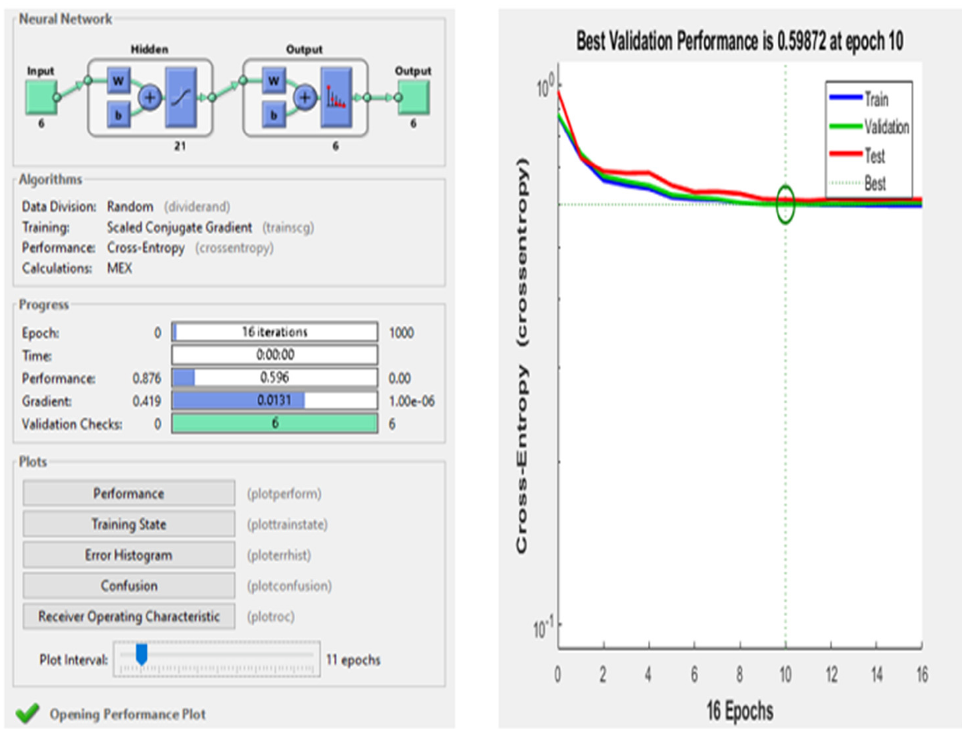
Figure 12. Neural network (NN) model.